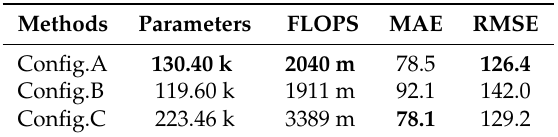
Table 2. Comparison of the proposed networks with different configurations on the ShanghaiTech Part A dataset. Config., configuration.